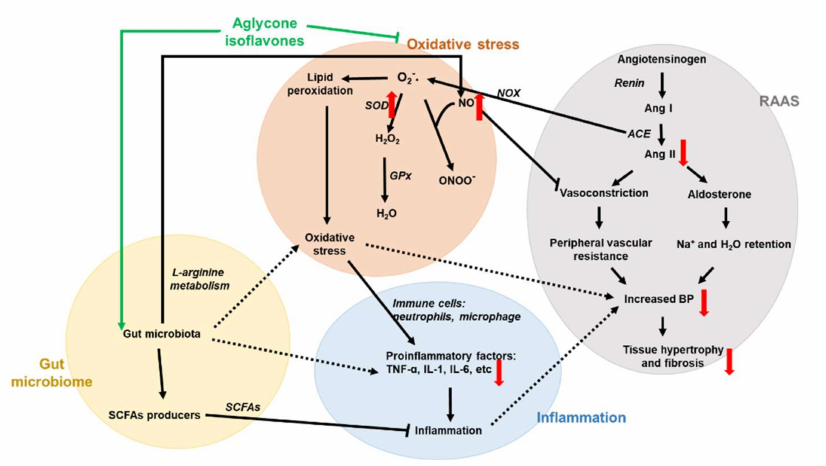
Figure 9. Proposed mechanism of L. rhamnosus AC1-fermented soymilk on DOCA-salt hypertensive rat. Four pathways are presented in this study, which are gut microbiota (yellow), oxidative stress (orange), RAAS (gray) and inflammation (blue). All the parameters are shown in the specific pathway. Black solid arrows represent a direct link between two parameters and black dotted arrows donate an indirect link. Red arrows mean the alteration of several biochemical parameters we evaluate. Green arrows indicate the active constituent in our fermented